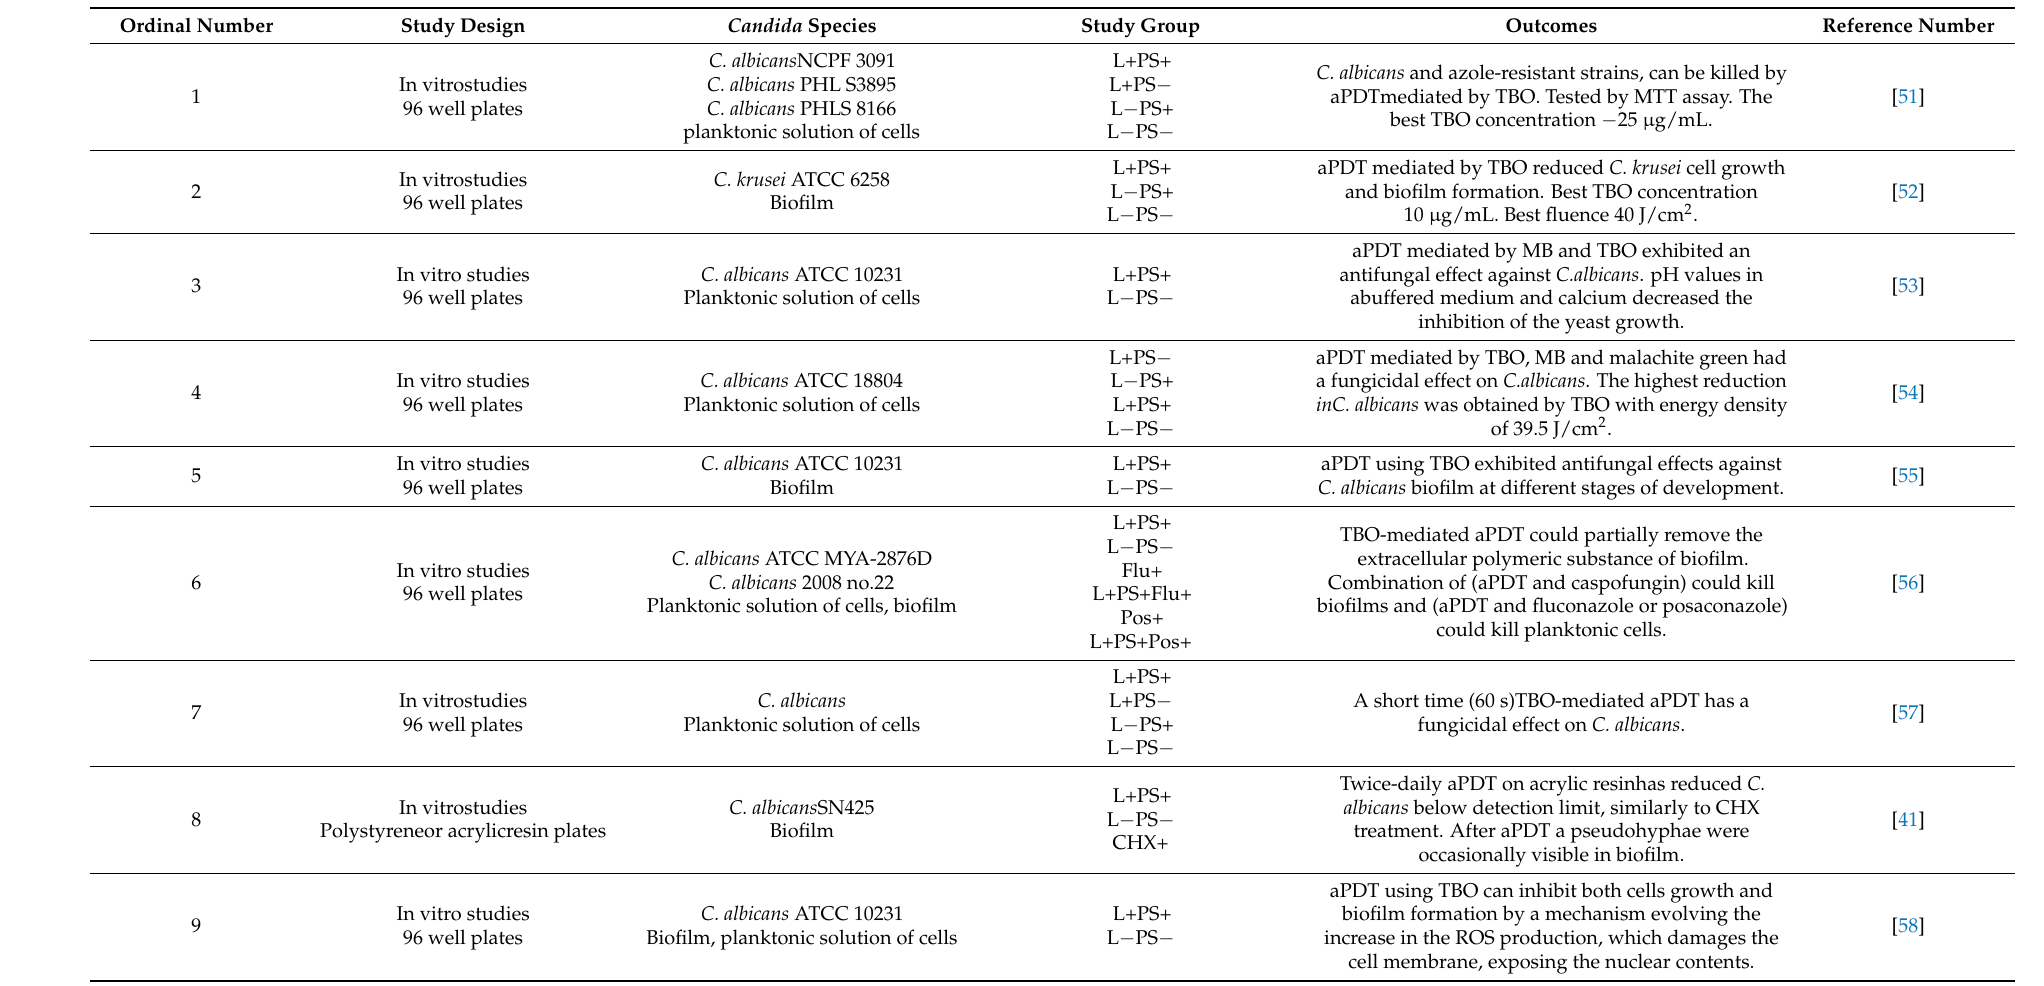
Table 2. Characteristicsof studies that fulfilled the eligibility